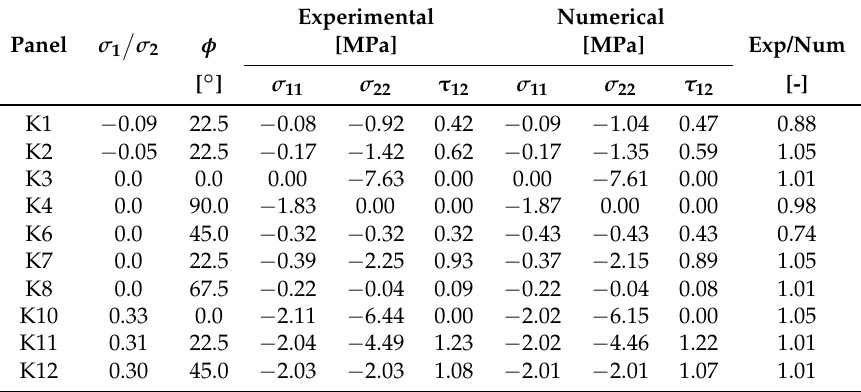
Table 1. Comparison of the proposed criterion with the experimental results of [36]. Experimental